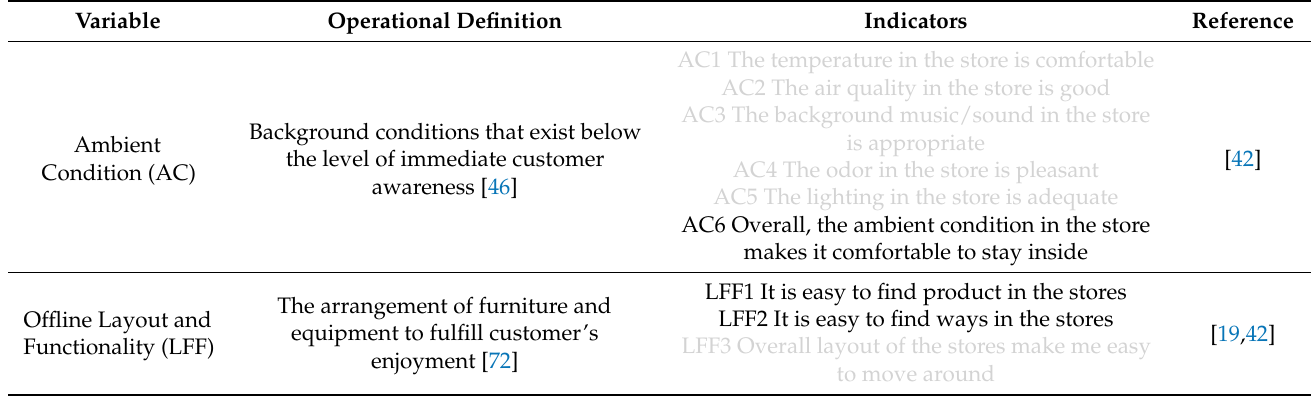
Table A1. Measurement instrument All items were measured using seven-point Likert-type scales that were anchored by 1 = strongly disagree, 2 = disagree, 3 = slightly disagree, 4 = neutral, 5 = slightly agree, 6 = agree, and 7 = strongly agree. In light gray, items removed in the final